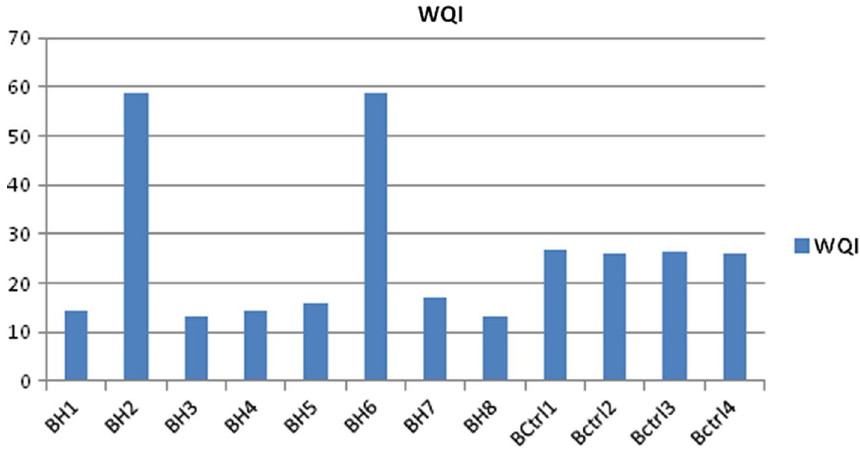
Fig. 2 WQI of the groundwater